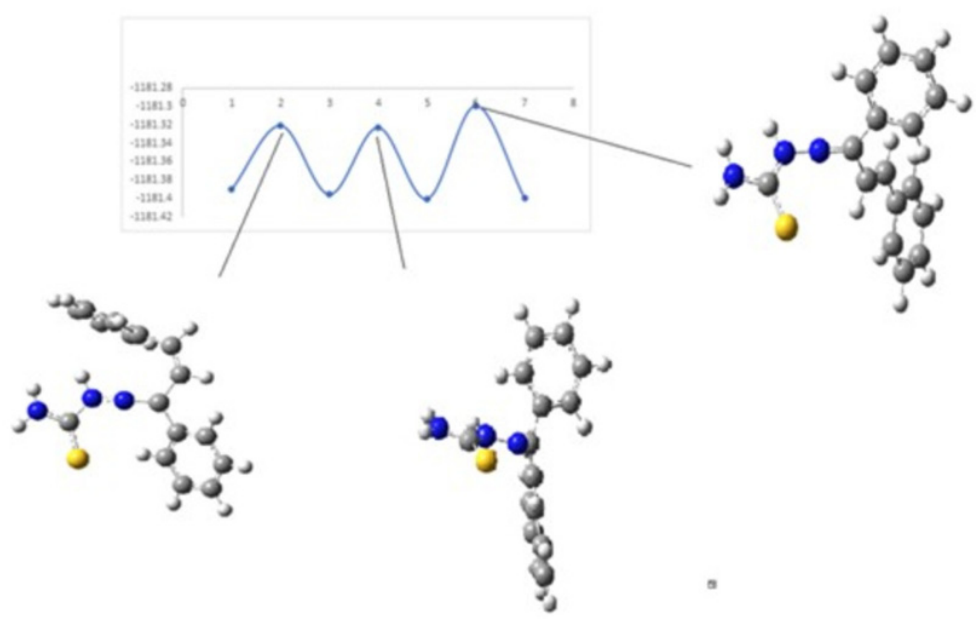
Figure 9. Schematic representation of cis − trans kinetic isomerization for KKI15 ( y = Energy in Hartree, x = conformation).